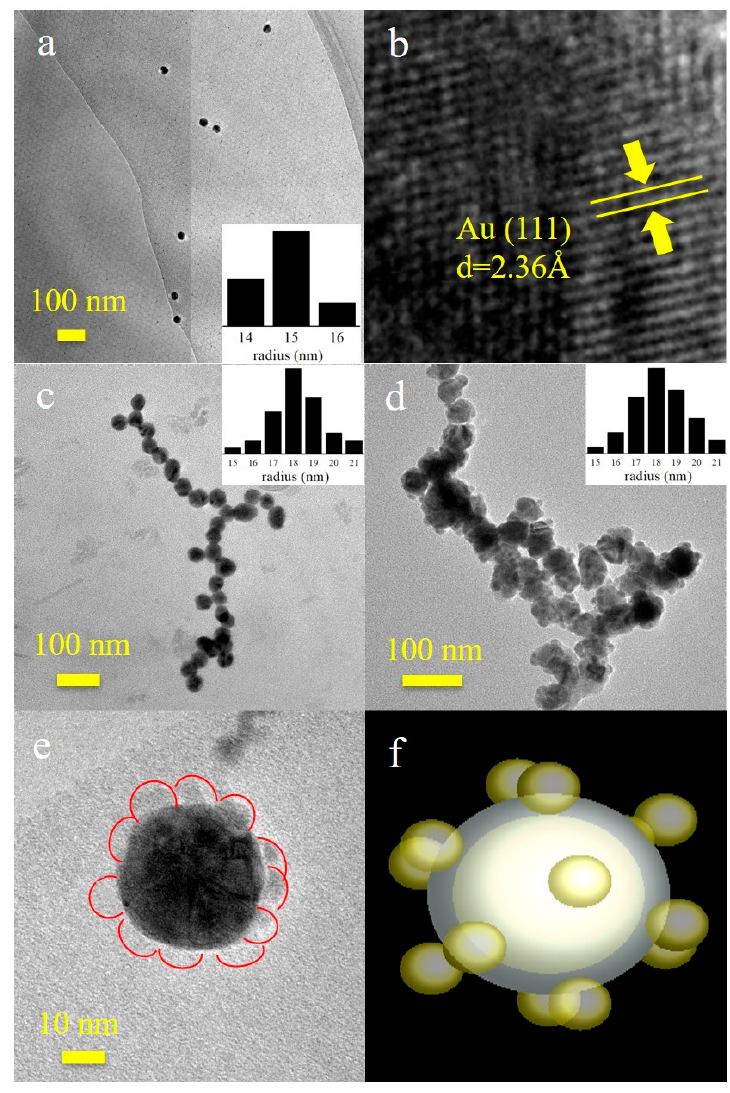
Figure 2. Transmission electron microscope (TEM) images and size distribution results of ( a ) Au NPs, ( c ) Au@Pt core-shell NPs, and ( d ) Au@Pt@Au core-shell NPs; ( b ) enlarged image of an Au NP; ( e ) high-resolution TEM (HRTEM) image; and ( f ) the three-dimensional model of an Au@Pt@Au core-shell NP.